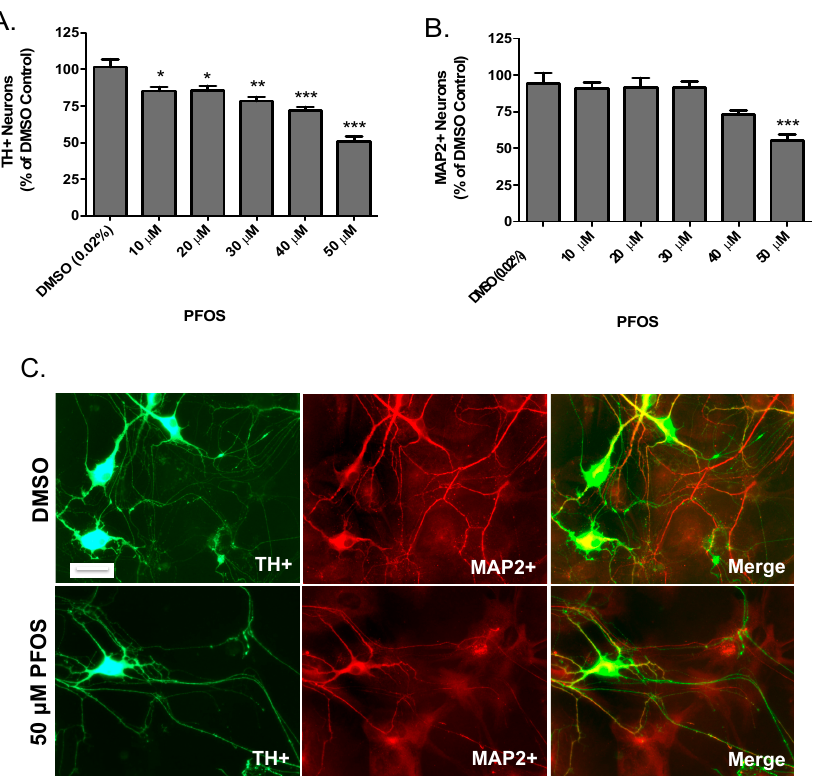
Figure 2. Acute exposure to PFOS results in a preferential reduction in the number of primary cultured dopaminergic neurons. ( A ) Treatment with PFOS resulted in a significant reduction in the number of TH+ neurons, beginning at 10 μ M; ( B ) treatment with PFOS did not elicit overt loss of non ‐ dopaminergic neurons (MAP+), except at the highest concentration of PFOS (50 μ M); and ( C ) representative images of TH+ and MAP2+ neurons following treatment with DMSO or 50 μ M PFOS. Scale bar: 10 µ m. Columns represent the percent change from DMSO control. Data represent the mean + SEM of 6 experimental replicates per treatment group performed over three separate experiments. * Values statistically significant from DMSO control ( p < 0.05). ** Values statistically significant from DMSO control ( p < 0.01). *** Values statistically significant from DMSO control ( p <